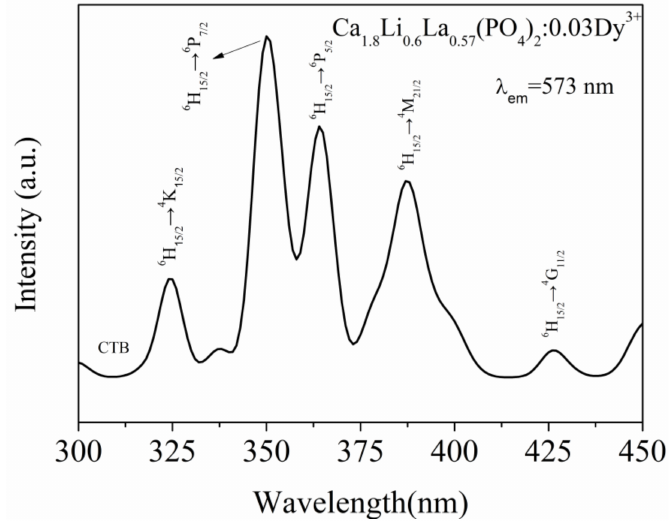
Figure 4. Photoluminescence excitation spectrum of Ca 1.8 Li 0.6 La 0.6 − x (PO 4 ) 2 :xDy 3+ phosphor. The photoluminescence emission spectra of Ca 1.8 Li 0.6 La 0.6 − x (PO 4 ) 2 :xDy 3+ (x = 0.01,